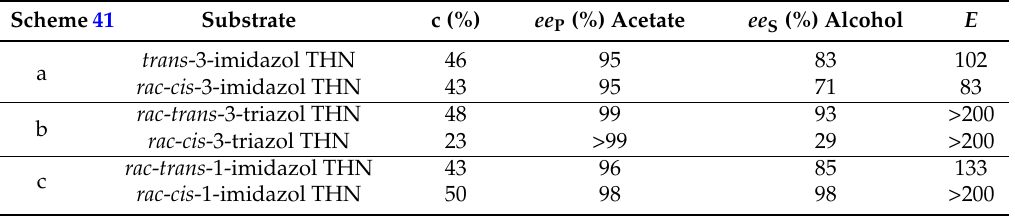
Table 5. Results from the enzymatic kinetic resolution of the racemic trans - and cis -3-imidazol THN (a),